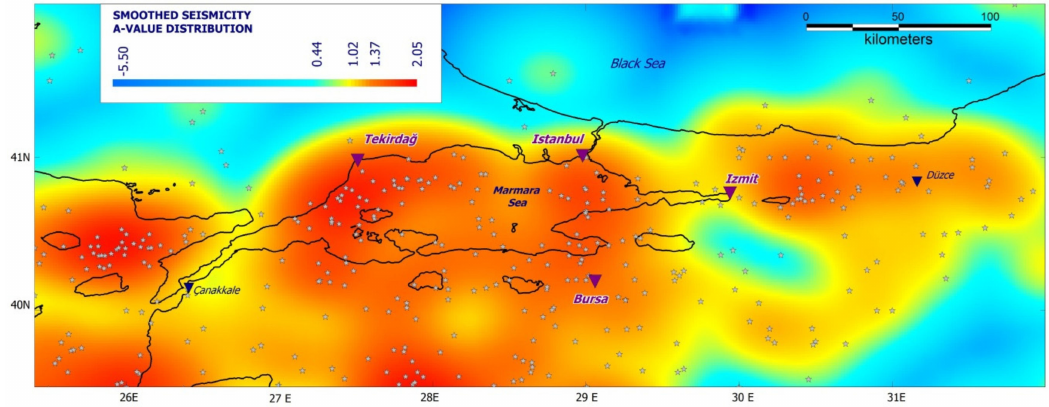
Figure 10. a-value distribution obtained with a smoothing kernel of 25 km. Stars indicate the catalogue of the post-1900 period with Mw <